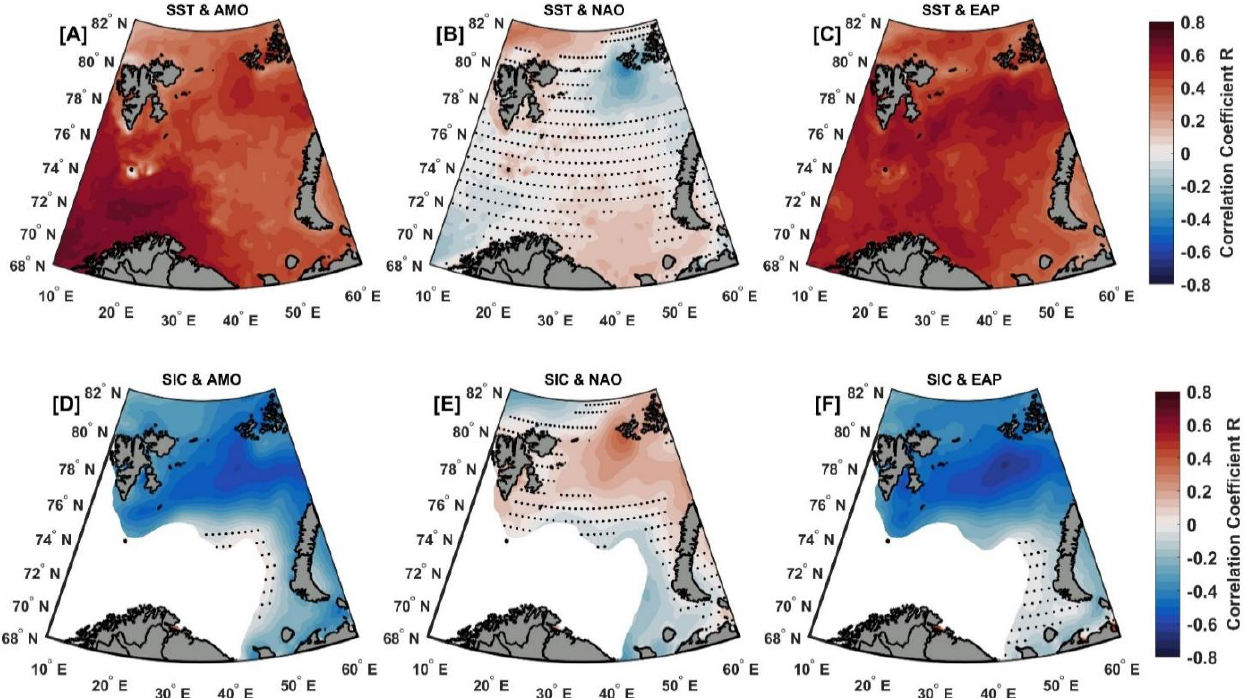
Figure 14. Spatial distribution of correlation coefficients between the interannual variability of SST (upper panels), SIC (lower panels) with the ( A , D ) AMO, ( B , E ) NAO, and ( C , F ) EAP over the period from 1982 to 2020. All data were filtered with a 13-month low-pass filter after the removal of seasonal climatology and then normalized.